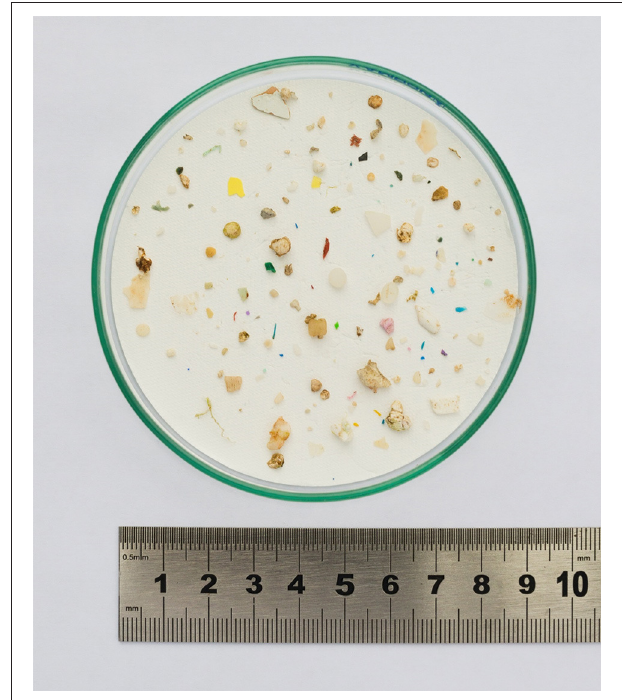
FIGURE 3 | Microplastics of various colors, shapes and sizes collected at sea.